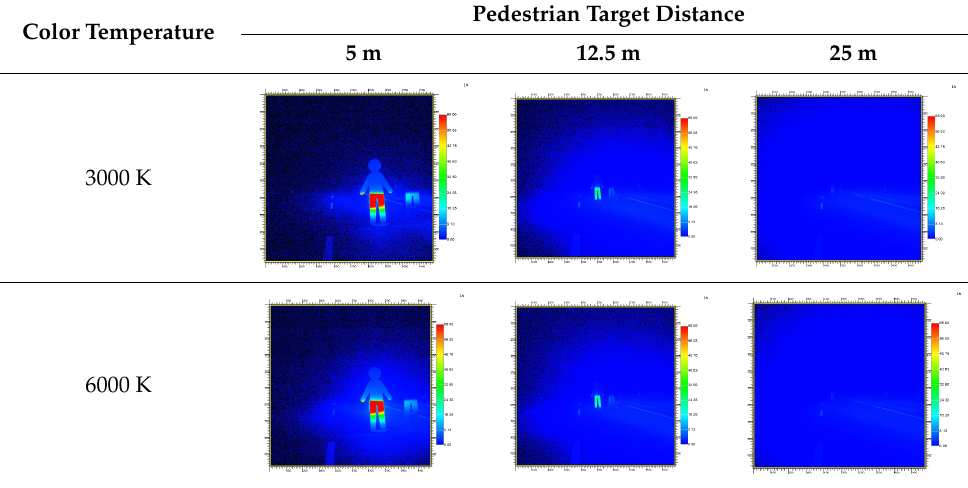
Table 7. Comparison of luminance by target distance and color temperature (fog 100 m).